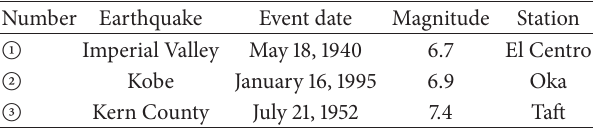
Table 2: Selection of seismic